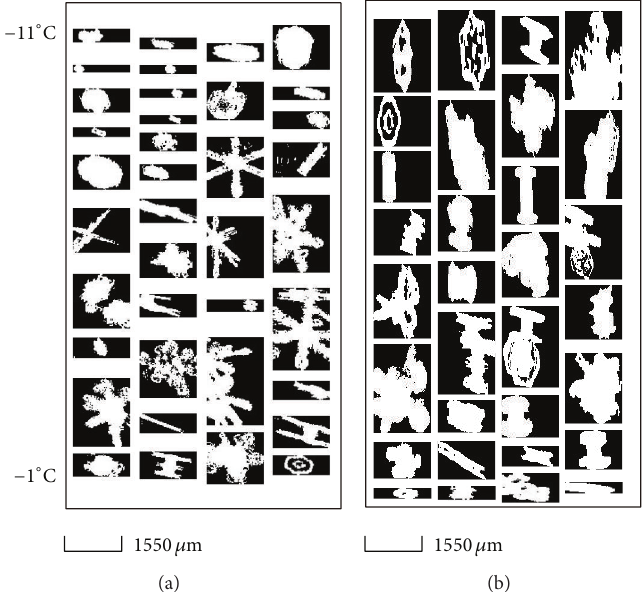
Figure 8: CIP images across the two flight ascents during (a) 1057 and 1122 CST and (b) 1723 and 1750 CST.